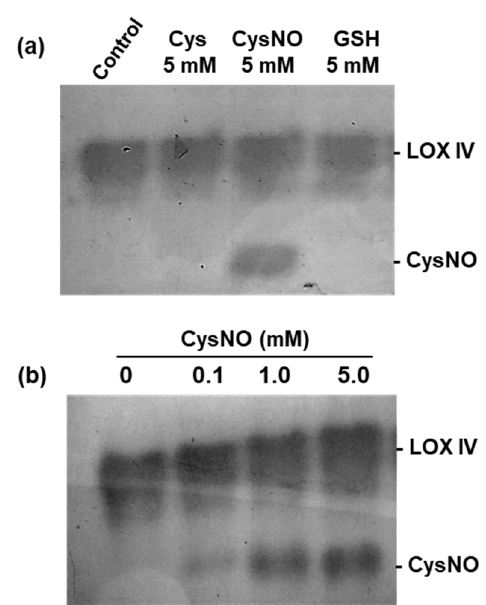
Figure 5. In ‐ gel lipoxygenase activity (LOX IV) assay in sweet pepper fruits in the presence of the NO donor S ‐ nitrosocyteine (CysSNO). ( a ) Effect of nitrosocysteine (CysSNO), cysteine (Cys) and reduced glutathione (GSH) as reductants. ( b ) Effect of CySNO concentrations on LOX IV. Treat ‐ ments with Cys, CySNO and GSH were conducted by incubating the pepper fruit crude extracts with these compounds at 25 ºC for 1 h before electrophoresis and further in ‐ gel LOX activity staining. Then, protein samples were separated by native PAGE (6% acrylamide) and gels were incubated with linolenic acid and staining solution containing N,N ‐ dimethyl ‐ p ‐ phenylenediamine until the appearance of pink bands (see material and methods for details).